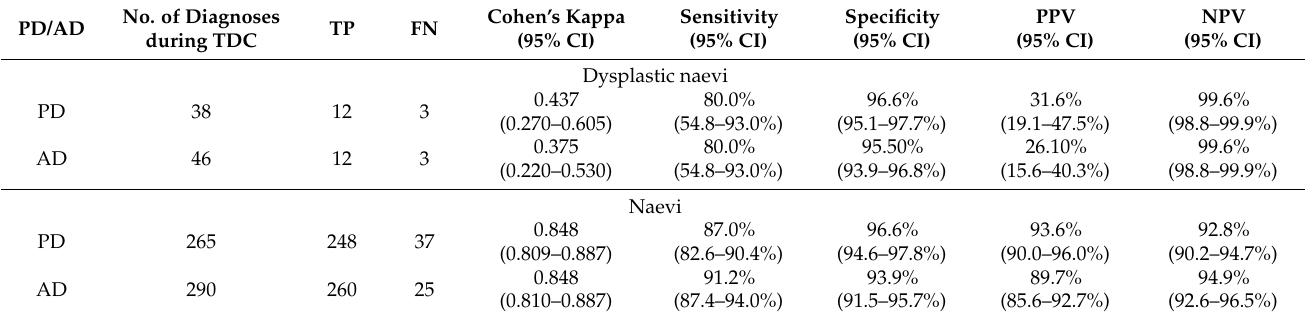
Table 5. Diagnostic parameters and concordance of dysplastic naevi and naevi groups.